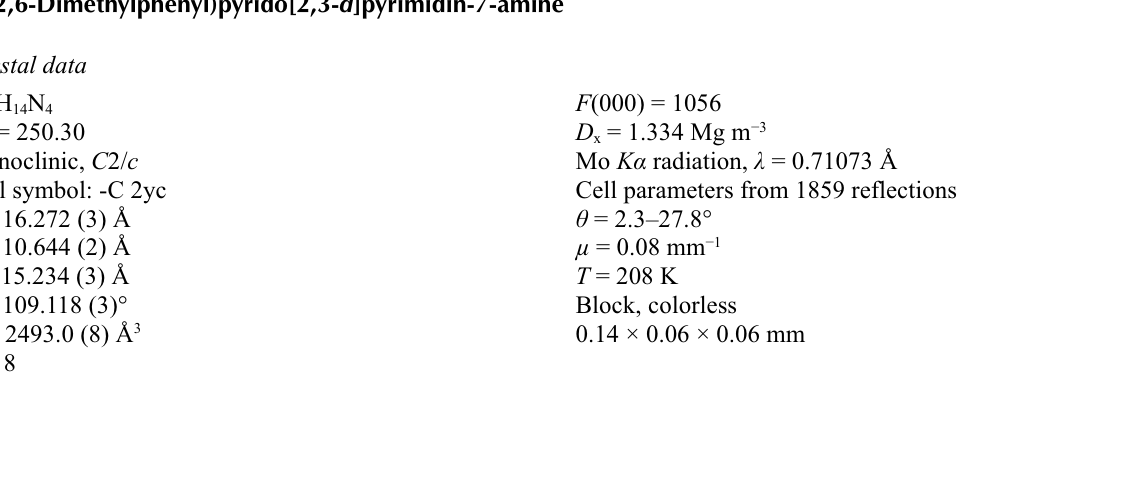
The crystal packing diagram viewed down the b -axis; H-bonds are shown as dashed